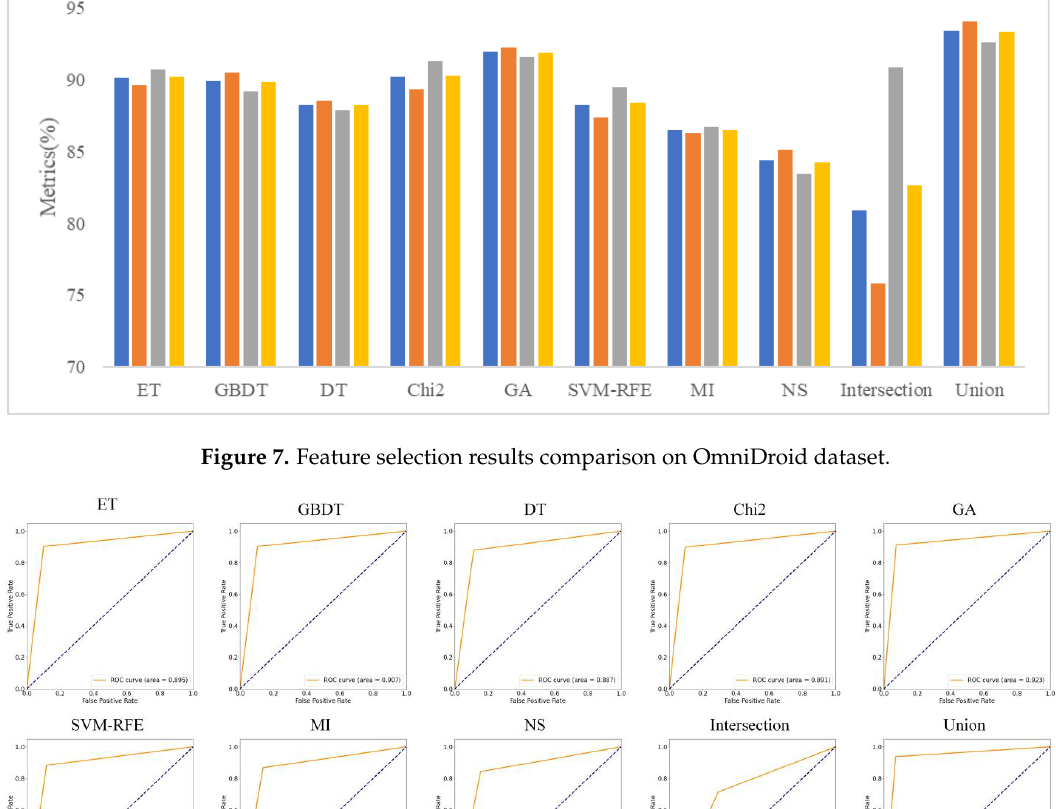
Figure 6. Confusion matrix of different feature selection methods on our dataset.